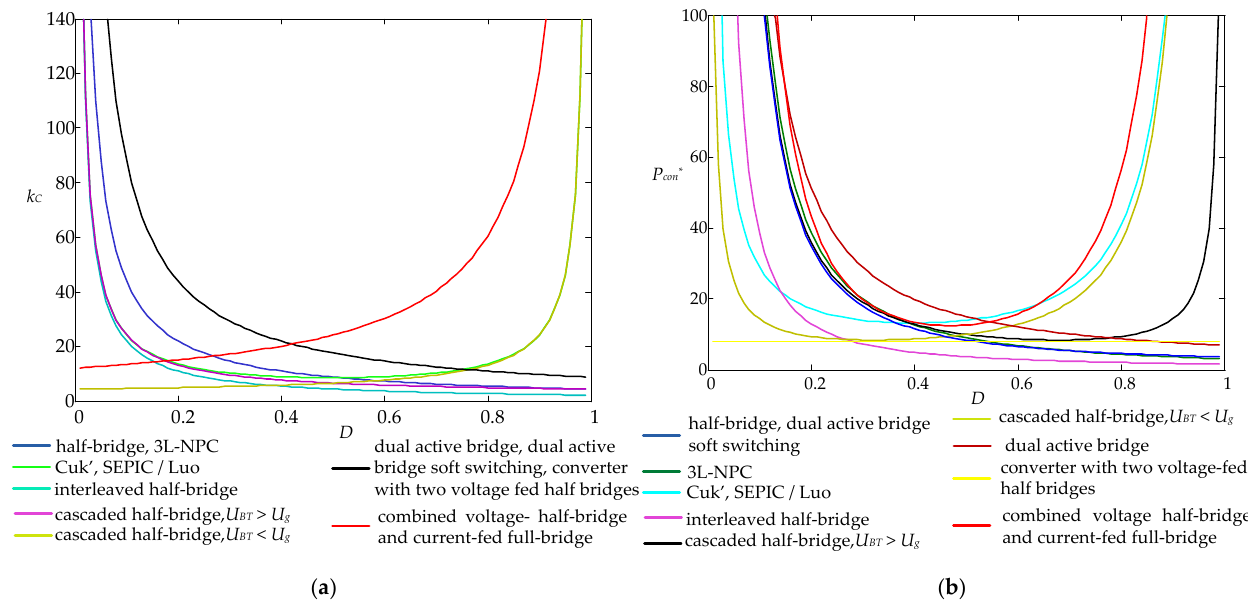
Figure 16. The cost factor k C and normalized power loss P con* of DC – DC energy storage ( a ) Cost factor k C ; ( b ) normalized power loss P con * in DC – DC energy storage converters.